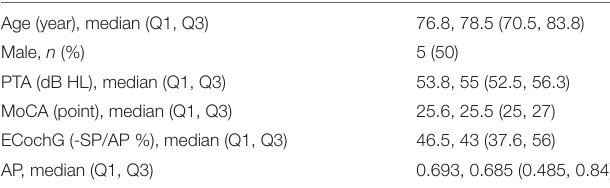
TABLE 2 | Demographic characteristics and audiometry results of 10 additional